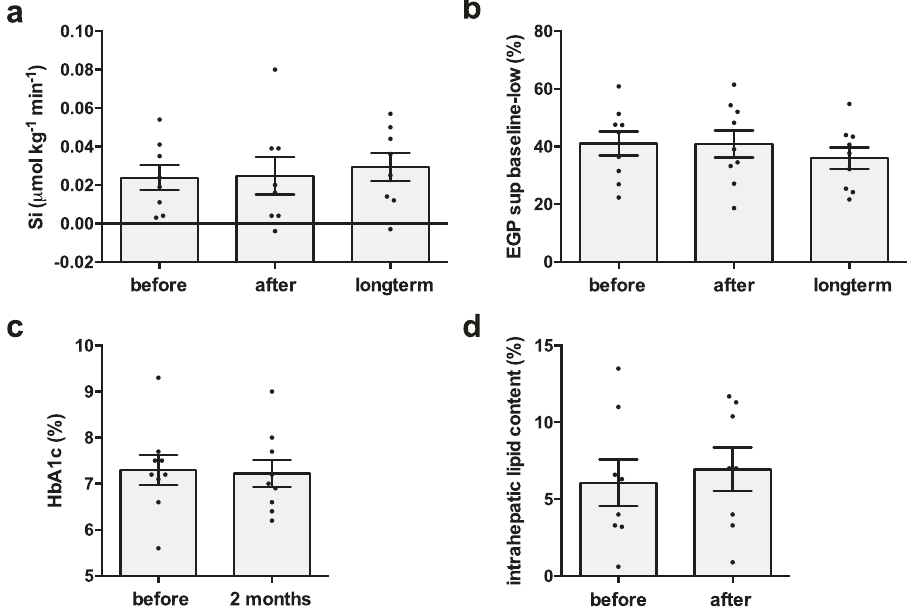
Fig. 5 Insulin sensitivity and intrahepatic lipid content. a Whole body insulin sensitivity ( n = 8). b Suppression of hepatic endogenous glucose production ( n = 9). c HbA1c before the cold acclimation and 2 months after the cold acclimation ( n = 9). d Intrahepatic lipid content ( n = 8). Data was analyzed with a two-sided Friedman test for Si and EGP. Data was analyzed with a two-sided Wilcoxon matched-pairs signed rank test for HbA1c and intrahepatic lipid content. Data are shown as individual datapoints and mean ±